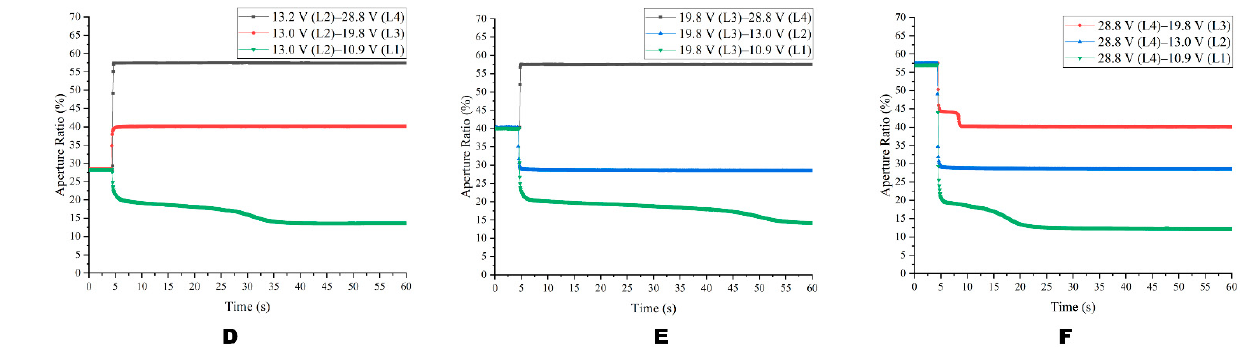
Figure 14. A change in switching between four gray scale levels driven by a square wave. ( A ) The square wave driving waveform experiment diagram. ( B ) The curve of the aperture ratio when V base changed from 0 V to L1~L4. ( C ) The curve of the aperture ratio when V base changed from L1 to L2~L4. ( D ) The curve of the aperture ratio when V base changed from L2 to L1, L3, and L4. ( E ) The curve of the aperture ratio when V base changed from L3 to L1, L2, and L4. ( F ) The curve of the aperture ratio when V base changed from L4 to L1~L3. Based on the stable driving phase, the overdriving pulse was added, and the driving waveform is shown in Figure 15A. The relevant parameters were 𝑤 = 23.26 ms ( 𝑓 = 43 Hz), 𝑡 (cid:2870) = 4.88 ms, 𝑡 (cid:2871) = 3.72 ms, 𝑉 (cid:3040)(cid:3028)(cid:3051) = 28.8 V and 𝑀 = 6. As shown in Figure 15B, dif-